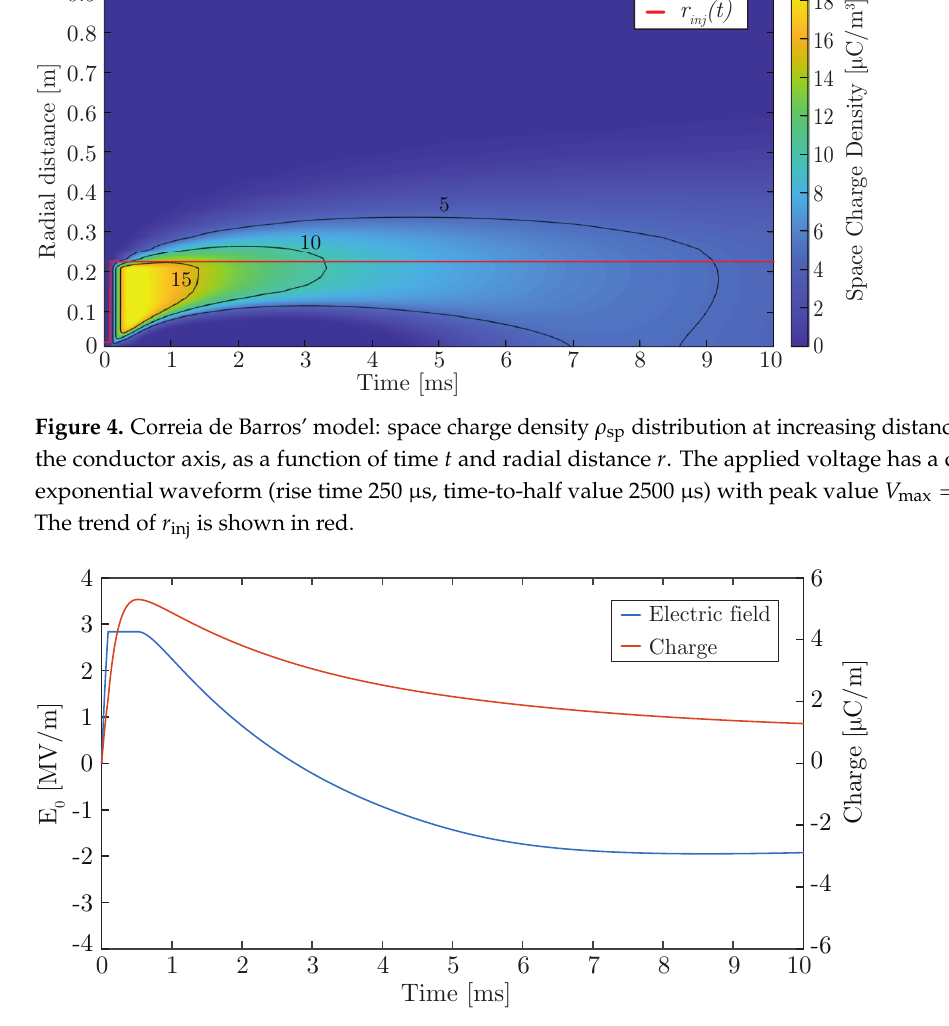
Figure 5. Correia de Barros’ model: trend of the electric field on the conductor surface E 0 (blue line) and of the total p.u.l. charge q (cid:48) (red line) as a function of time under the same simulation conditions in Figure